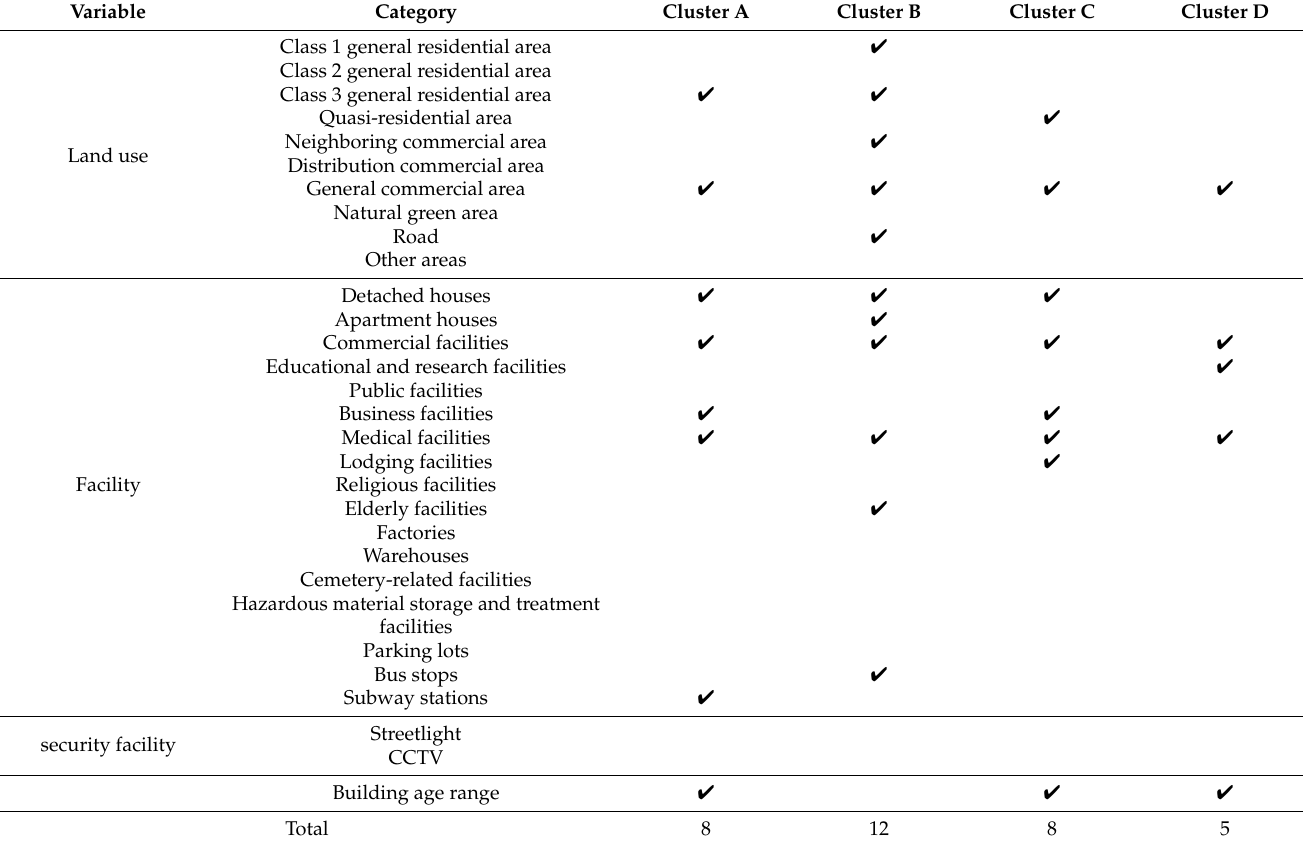
Table 4. List of significant variables for